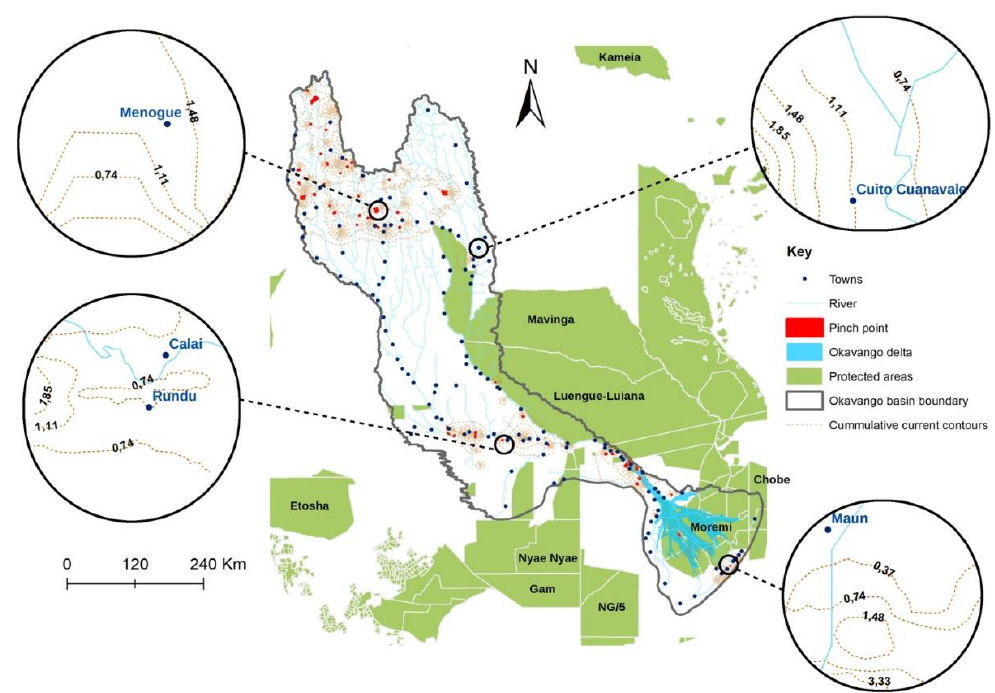
Figure 6. The map shows contours of cumulative current for Category A transitions (from natural to artificial classes) in relation to towns and rivers, and protected areas. The subfigures highlight how current ranges are influenced by the locations of selected towns in the basin.